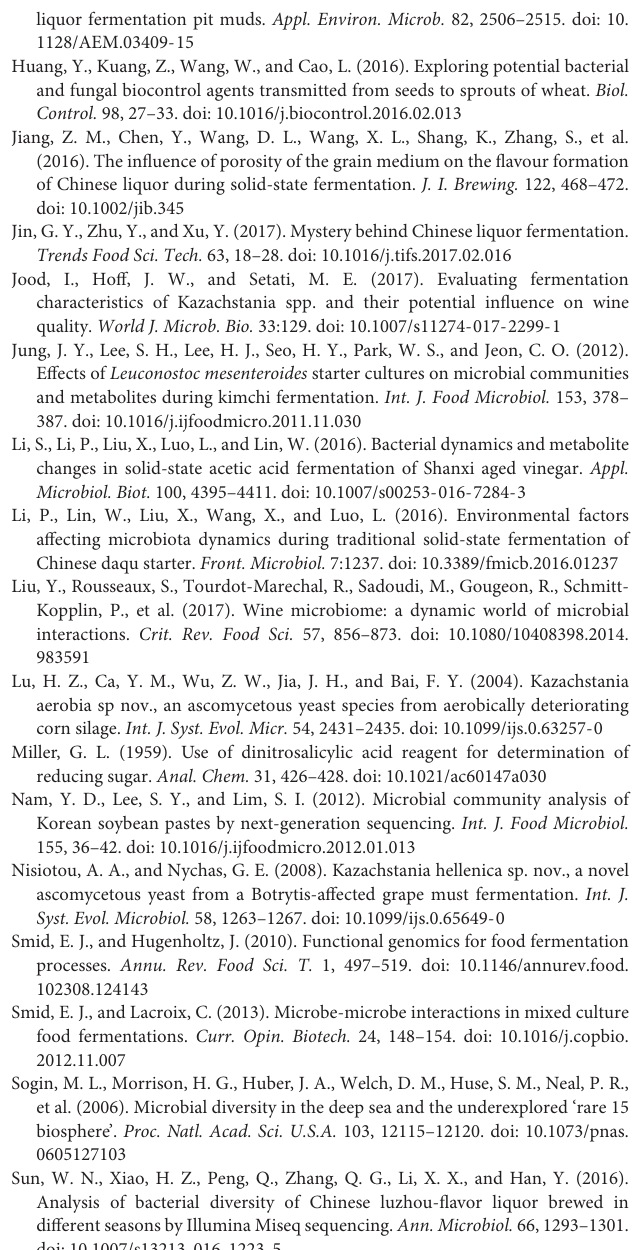
FIGURE S1 | Sampling design. Every FG sample ( (cid:78) ) was collected from six different positions (the upper layer of pit and the middle layer of pit, 200 g FG at each position), and well mixed as one sample. FIGURE S2 | Rarefaction analysis of the next generation sequencing of the bacterial 16S rRNA (A) and fungal ITS1 (B) gene from FG based on